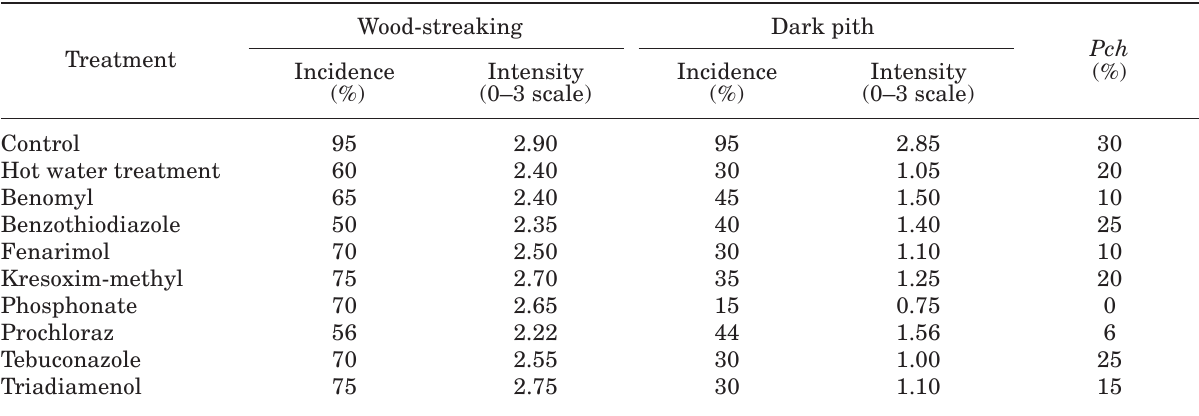
Table 2. Effect of treatments on symptom appearance (brown wood-streaking and dark pith) and presence of Pch (sporulation in wet chamber) in one-year-old Pinot Noir rootlings. Incidence of symptom was measured as the per- centage of 20 vines per treatment showing discolouration; intensity of symptom was assessed using a scale of 0–3, where 0 = no discolouration, 1 = faint discolouration, 2 = moderate discolouration and 3 = strong discolouration. The values are expressed as the average over 20 vines per